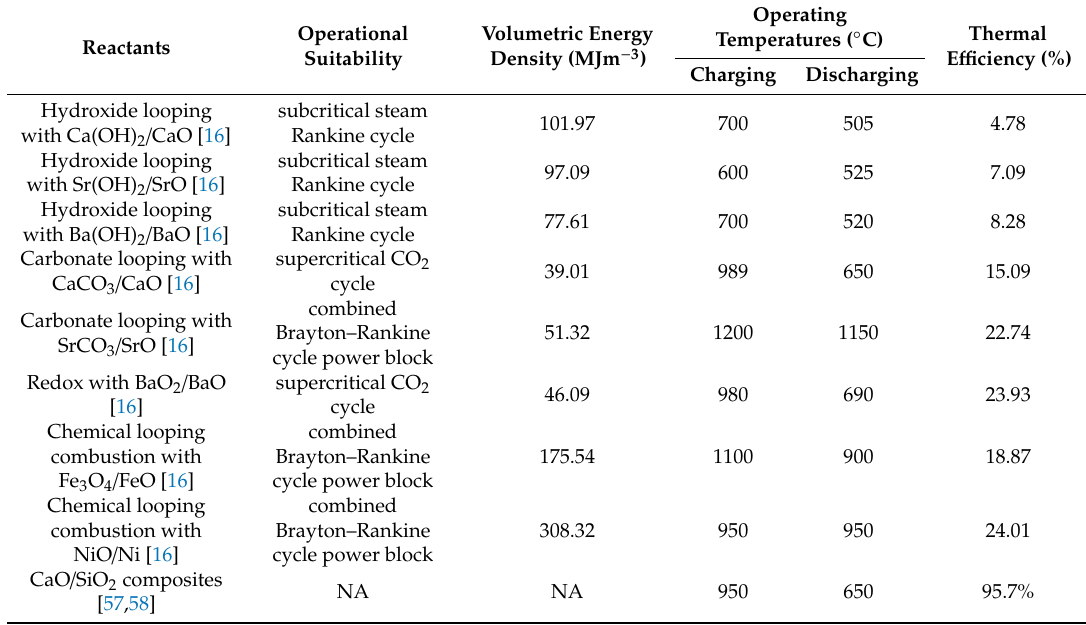
Table 3. Summary of recent materials with their properties for thermo-chemical energy storage.